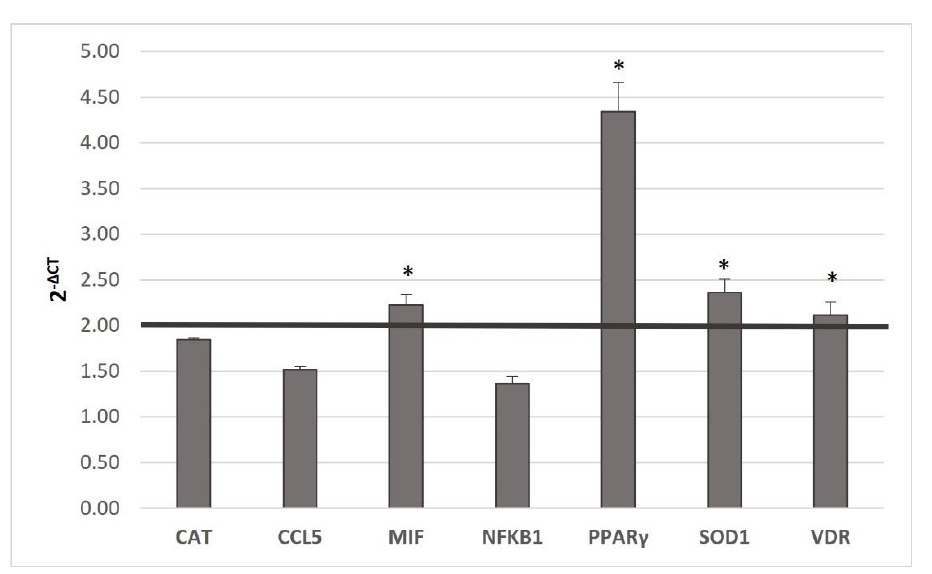
Figure 2. Gene expression between MedDiet and MedDiet + MAB juice. Gene expression is expressed as 2 − ∆ CT . A paired t -test was made to assess differences. Statistical significance was assigned as * p < 0.05. Abbreviations: Catalase ( CAT ); Chemokine C-C motif ligand 5 ( CCL5); Macrophage Migration Inhibitory Factor ( MIF ); Nuclear Factor Kappa B Subunit 1 ( NFKB1 ); Peroxisome Proliferator Activated Receptor γ ( PPAR γ ); Superoxide Dismutase ( SOD1 ); Vitamin D Receptor ( VDR ). MIF ( p ≤ 0.05), PPAR γ ( p < 0.001), SOD1 ( p ≤ 0.05), and VDR ( p ≤ 0.05) expressions in- creased significantly ( p ≤ 0.05) in the comparison between MedDiet, and MedDiet +